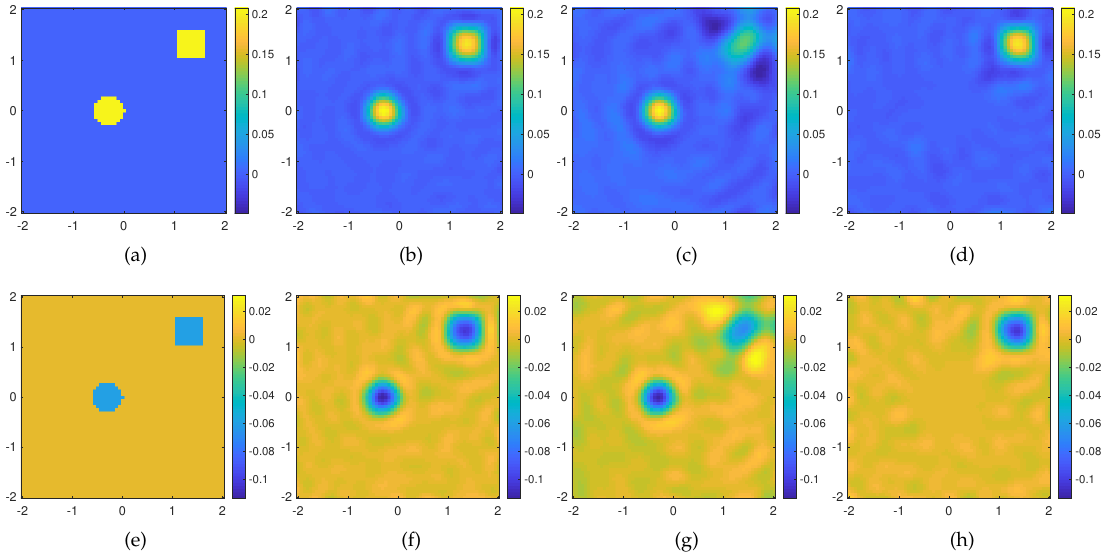
Figure 4. Reconstruction of a two small weak scatterers through the Born approximation. ( a ) Real and ( e ) imaginary part of the actual contrast profile; ( b ) real and ( f ) imaginary part of the recovered contrast profile for (cid:96) = 0, ± [ 1 − 18 ] , err = 0.2241 with a cutoff value in the TSVD equal to N T = 252; ( c ) real and ( g ) imaginary part of the recovered contrast profile for (cid:96) = 0, ± [ 1 − 4 ] , err = 0.4017 with a cutoff value in the TSVD equal to N T =166; ( d ) real and ( h ) imaginary part of the recovered contrast profile for (cid:96) = ± [ 6 − 11 ] (without the lowest order modes), err = 0.60 with a cutoff value in the TSVD equal to N T = 187. The axes of the imaging domain are expressed in background